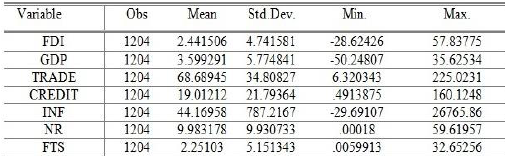
Table 1: Descriptive Statistics